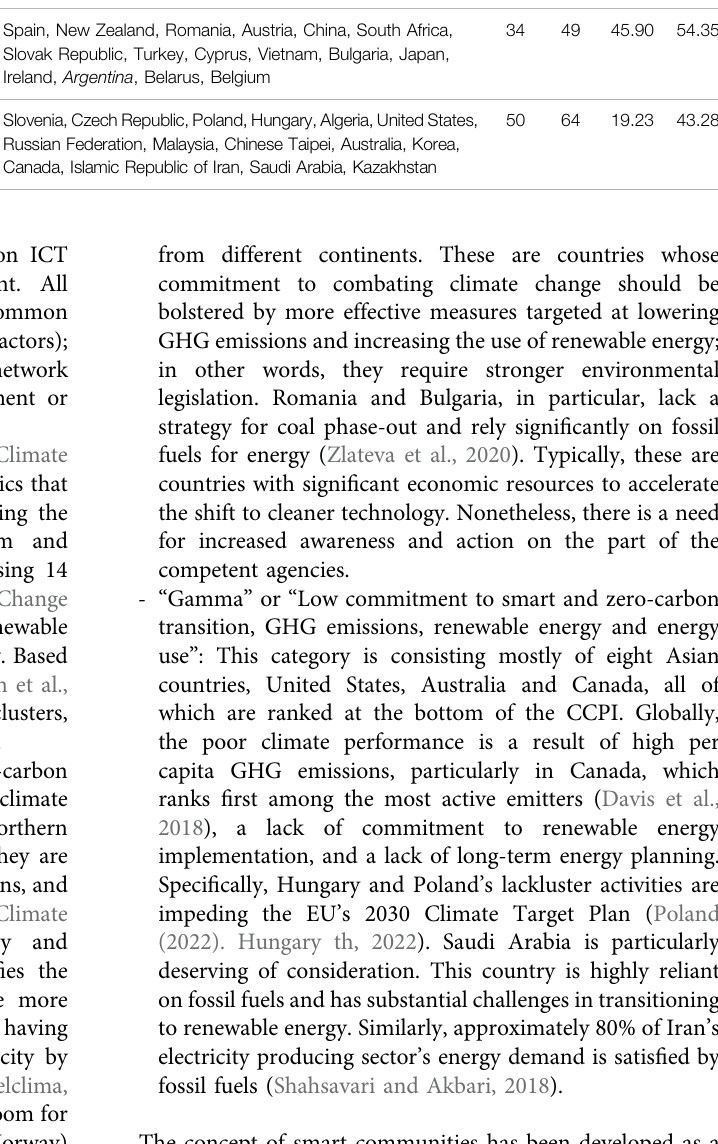
TABLE 1 | Climate Change Performance Index 2022 — Rating table. Clusters